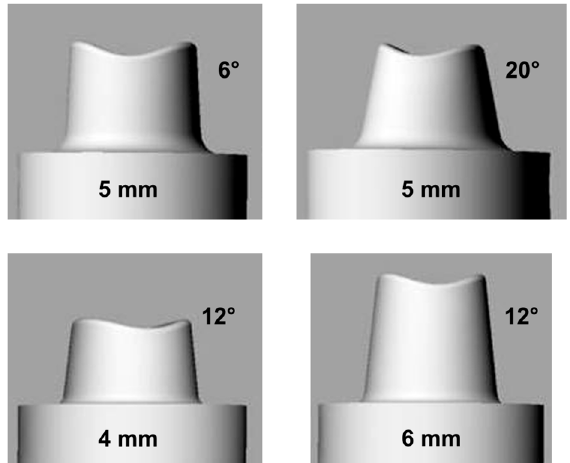
Figure 2. Representation of the preparations design. The groups with 6° and 20° of convergence angle tooth preparation have 5 mm height, while the groups with 4 and 6 mm of height have 12° convergence angle.